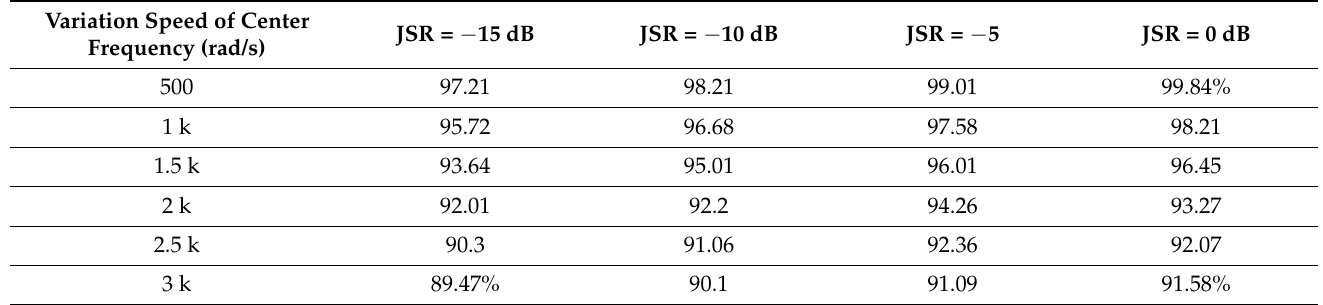
Table 3. Detector performance in the practical